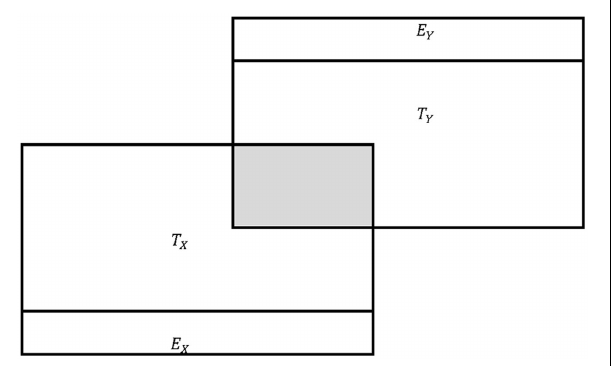
FIGURE 1 | Conceptual representation of observed score variance in the case of no correlated error. T , true scores; E , error scores. Note: shaded area denotes shared variance between T X and T Y .